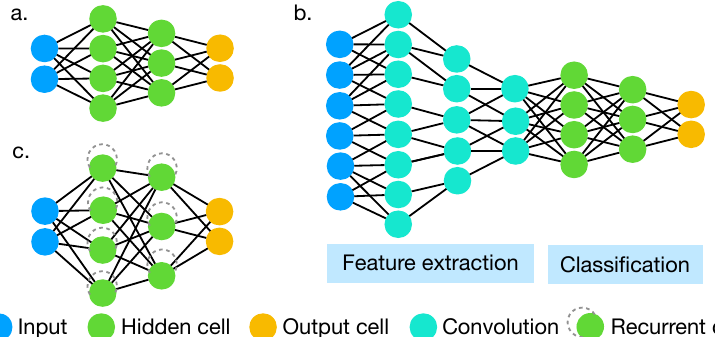
Figure A1. Network architectures. ( a ) Fully-connected; ( b ) Convolutional neural network; ( c ) Recurrent neural